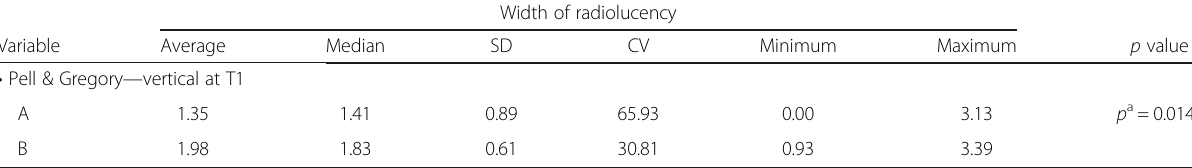
Table 5 Statistic analysis of the width of radiolucency according to the Pell and Gregory and final Winter ’ s classification at T1 Width of